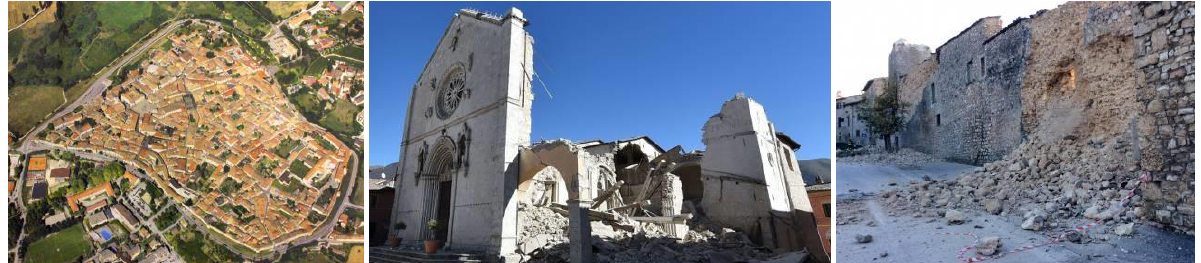
Figure 2. View on Norcia before the earthquake (left) and examples of damages caused by the earthquake on 30/10/2017 (source: